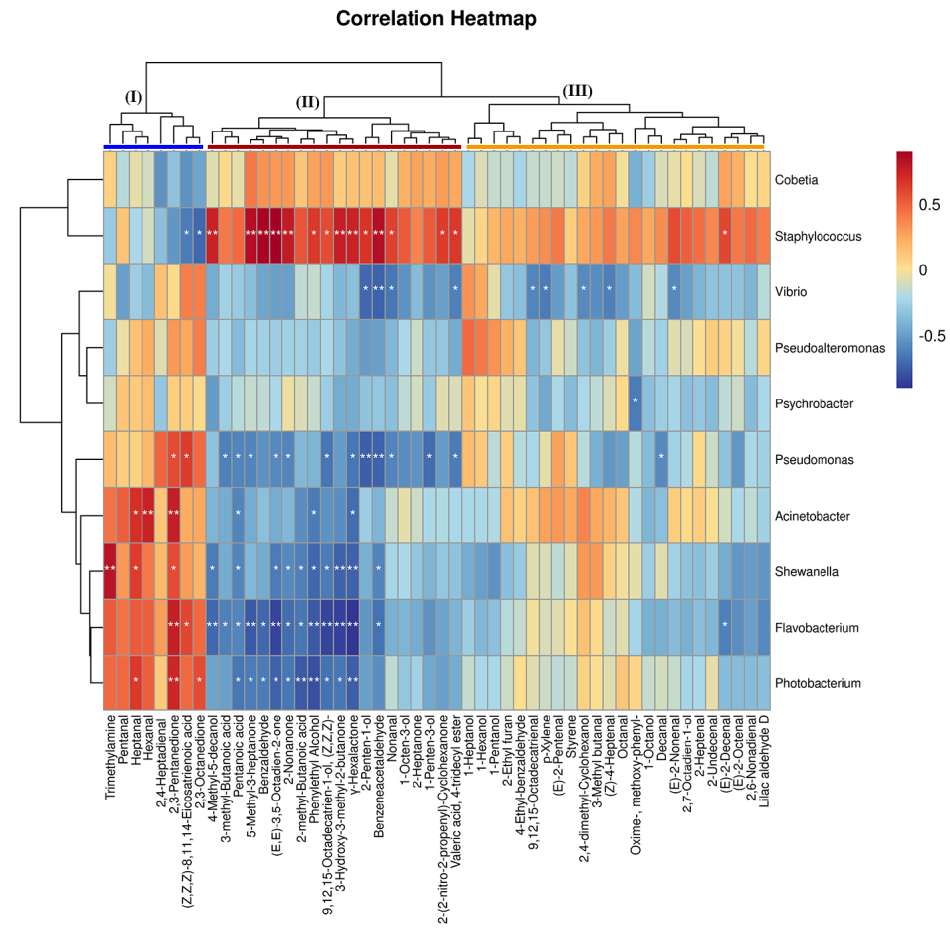
Figure 5. Heatmap of Spearman’s rank correlation between the top 10 genera and volatile compounds in salted herrings. ** Rho > 0.7, p < 0.01; * 0.6 < Rho < 0.7, p < 0.05.